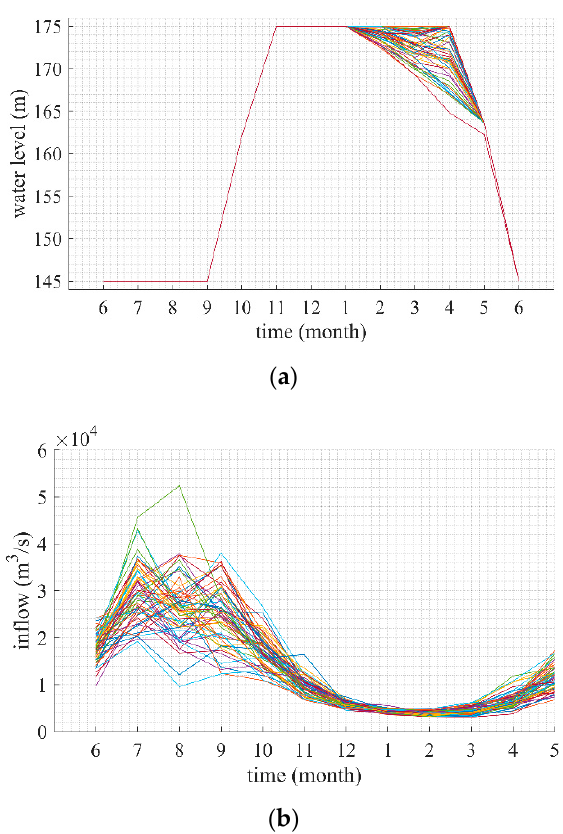
Figure 5. The optimal control water level and inflow of the dataset from 1959 to 2014. ( a ) optimal control water level { Z ∗ }, ( b ) inflow sequence { I t